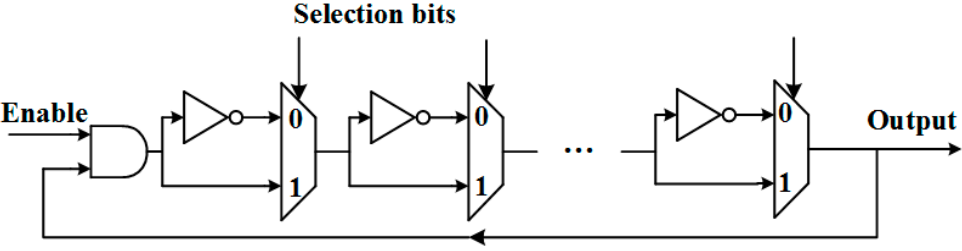
Figure 3. Architecture of the configurable RO [17].